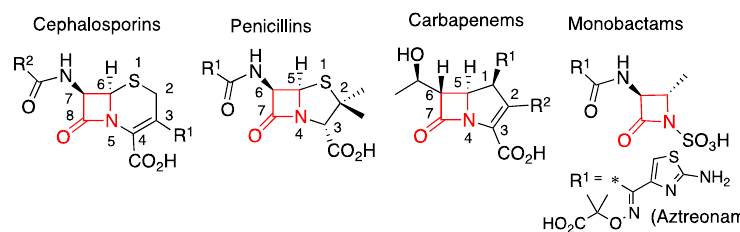
Figure 1. General sca ff old of clinical β -lactam antibiotics with their respective atom numbering. The β -lactam ring is shown in red.